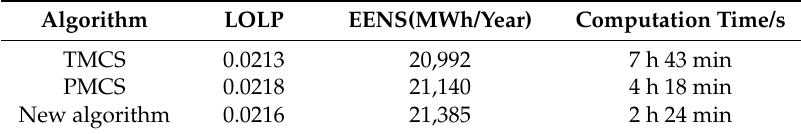
Table 4. The reliability indices of practical system obtained via different